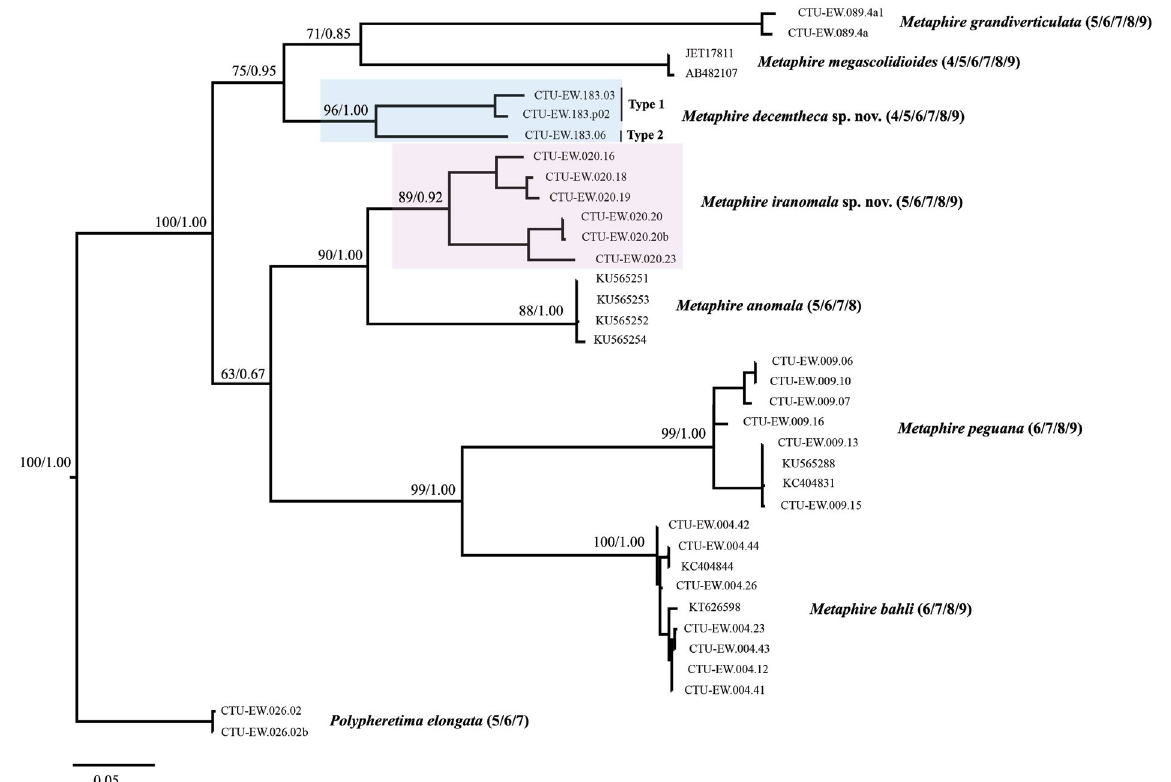
Fig. 4. The phylogenetic diagram inferred from the 594 bp dataset using the Maximum Likelihood (ML) and Bayesian Inference (BI) analysis. The values at node show the bootstrap and BI. The information in parentheses are locations and number of spermathecal